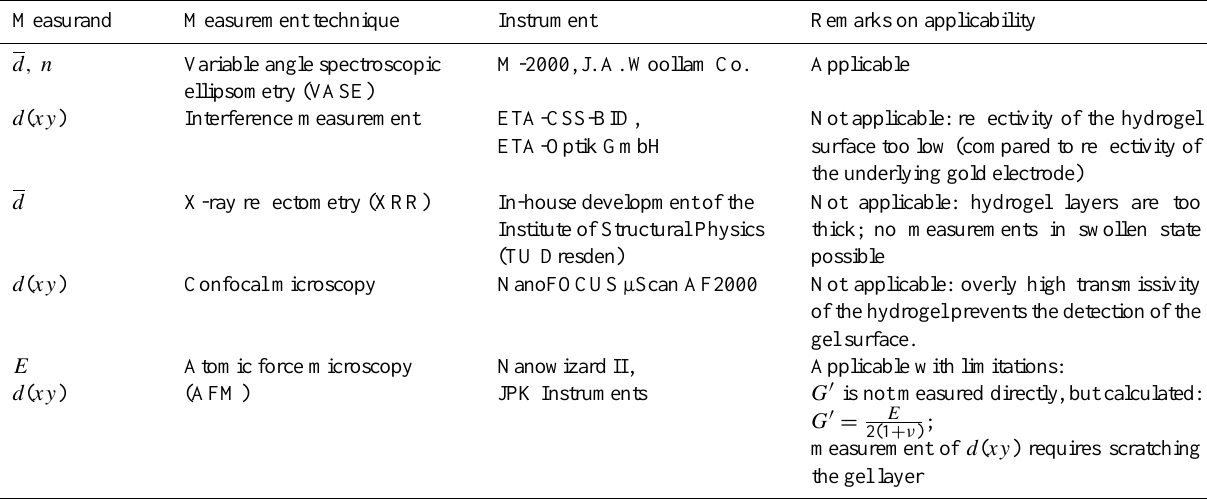
Table A2. Tested measurement techniques and their applicability for thin hydrogel